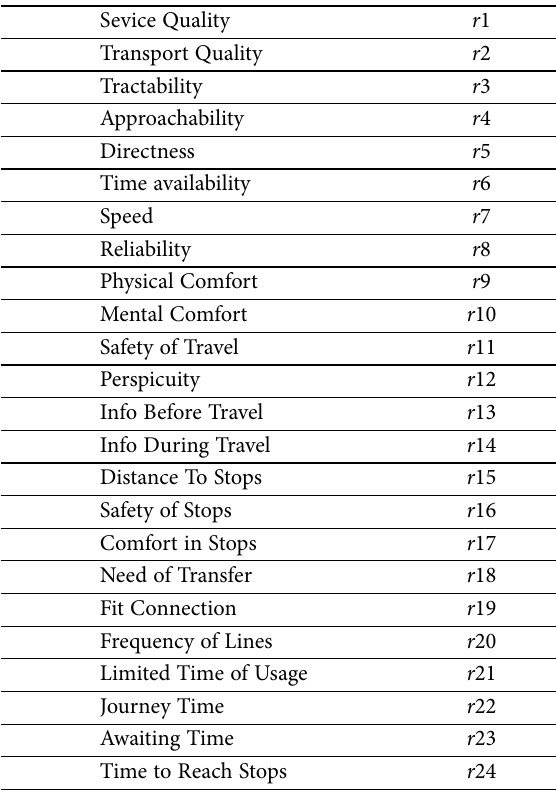
Table 1. The notation of system